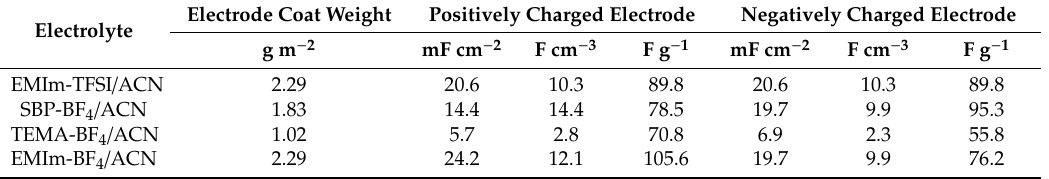
Table 3. Capacitance values obtained from constant current discharge plots at I = 0.5 mA cm − 2 . Electrode Coat Weight Positively Charged Electrolyte